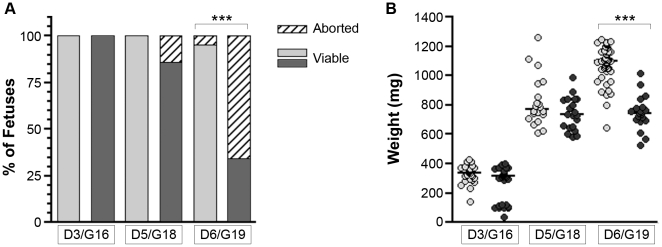
Experimental model recapitulates the spontaneous abortion and low birth weight outcomes characteristic of PM.
(A) Pregnant BALB/c females infected (dark bars) with P. berghei on gestational day (G)13 have an increased rate of abortion and decreased proportion of viable pups per litter compared to uninfected mice (light bars) by G19, day 6 of infection/control injection (D6). Proportion of viable fetuses depicted by solid bars; aborted fetuses, by striped bars. (B) Body weight of viable fetuses is decreased with maternal malaria infection (dark symbols) as compared to weight of fetuses from uninfected mice (light symbols). Dots are individual viable fetuses; bars represent the median of each group. 20–83 fetuses were collected per group (from 4–13 pregnant females per group). *** P<0.001 (Mann-Whitney).